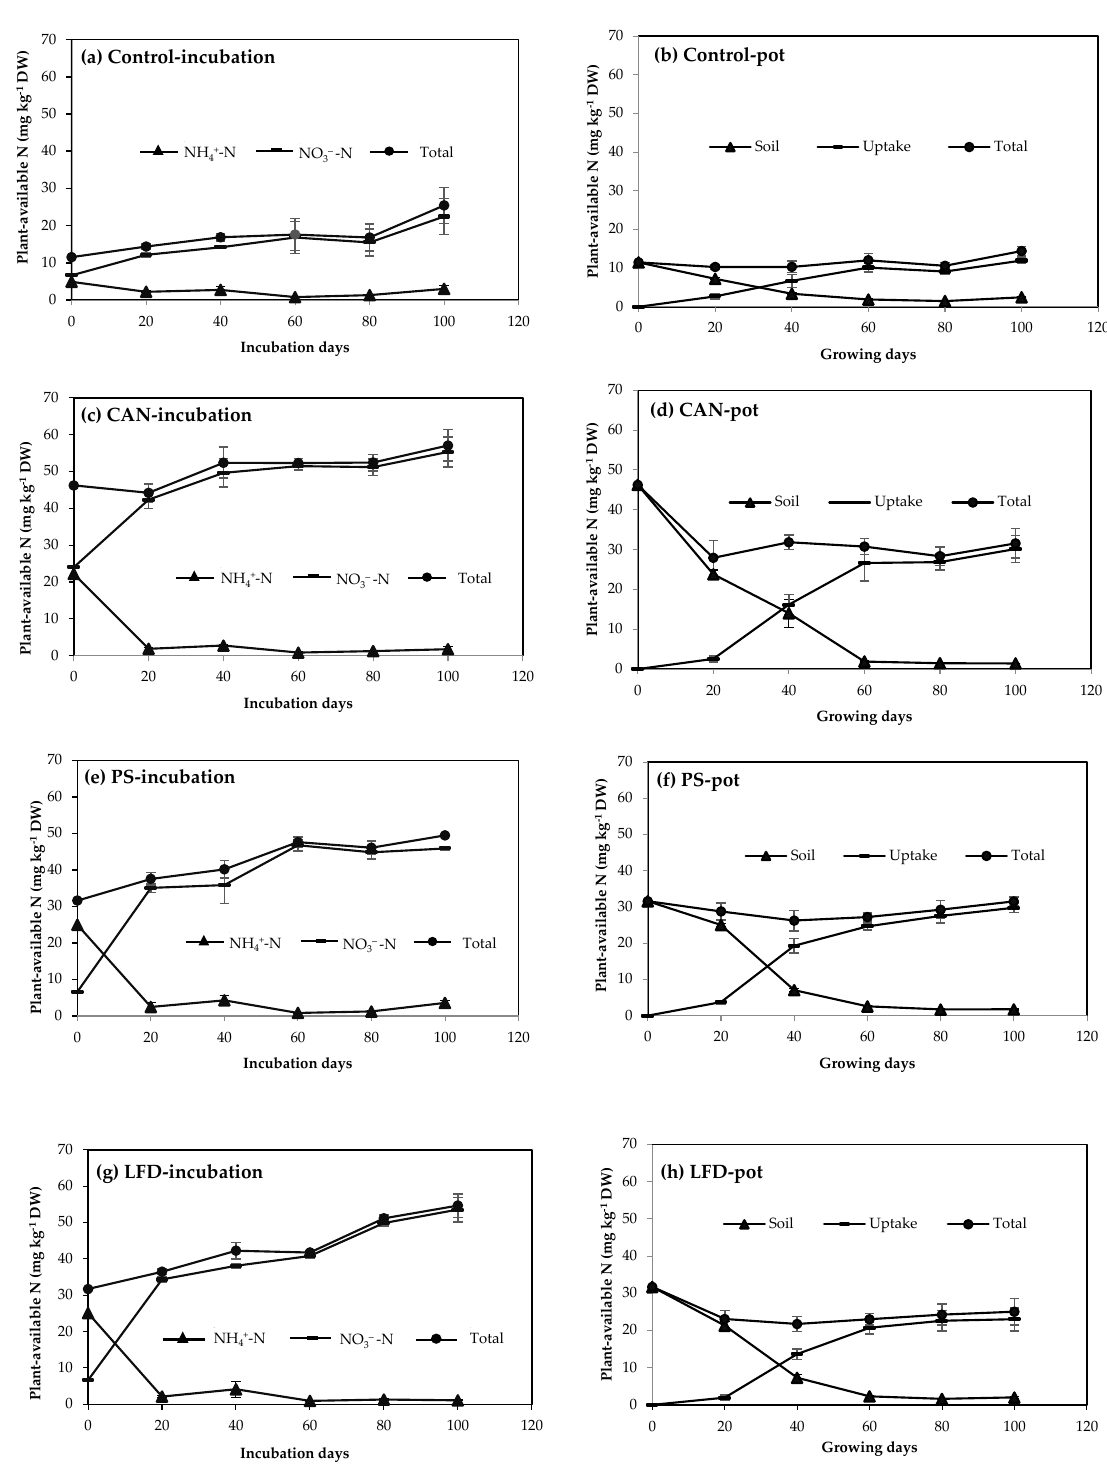
Figure 3. Dynamics of plant-available N (mg kg − 1 dry weight (DW), mean ± standard deviation; n = 4) in the soil of incubation ( a , c , e , g ) and maize-growing pot ( b , d , f , h ) in 100 days. No N fertilizer-control ( a , b ), calcium ammonium nitrate— CAN ( c , d ), pig slurry—PS ( e , f ), and liquid fraction of digestate—LFD ( g , h ). Data at t = 0 were estimations according to measurements in the control and the fertilizer application rate. In maize-growing pots, total plant-available N was calculated as the sum of mineral N in the soil and N uptake in the roots and